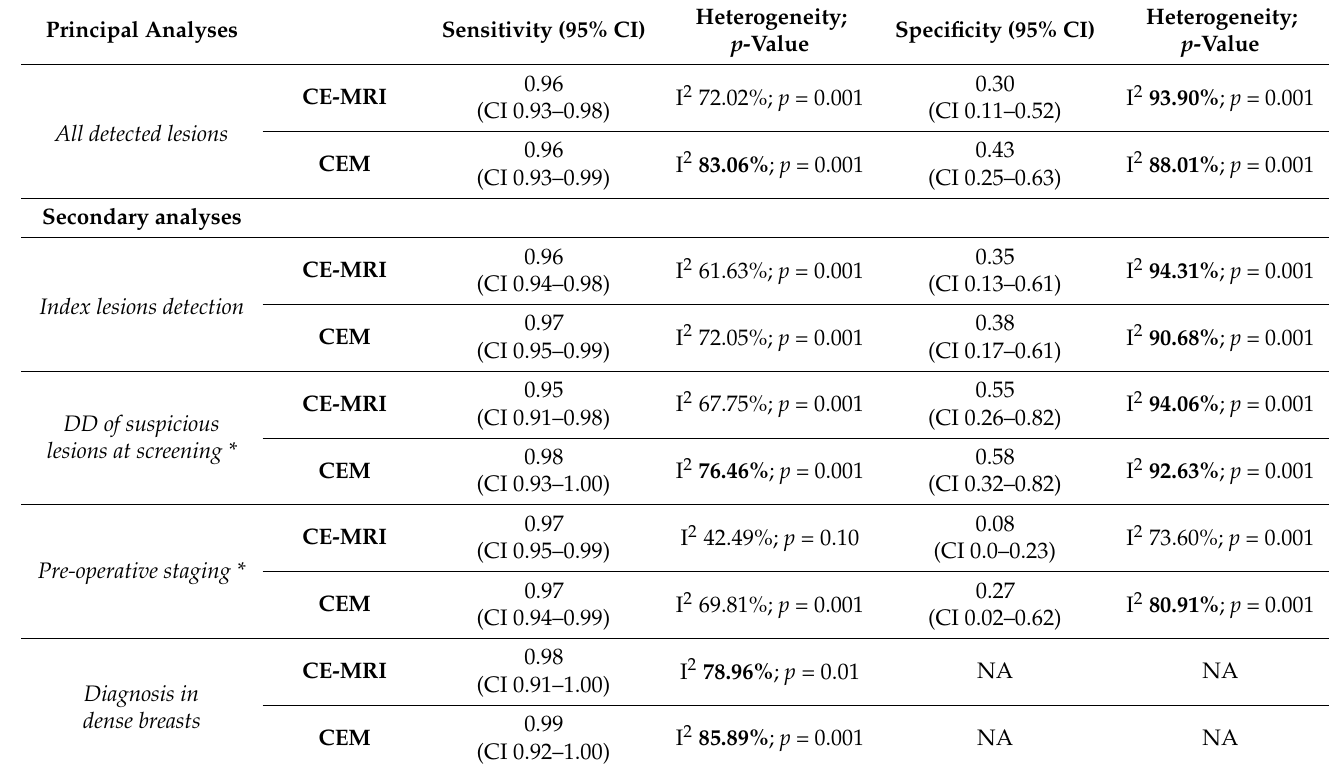
Table 1. The results of all of the analyses